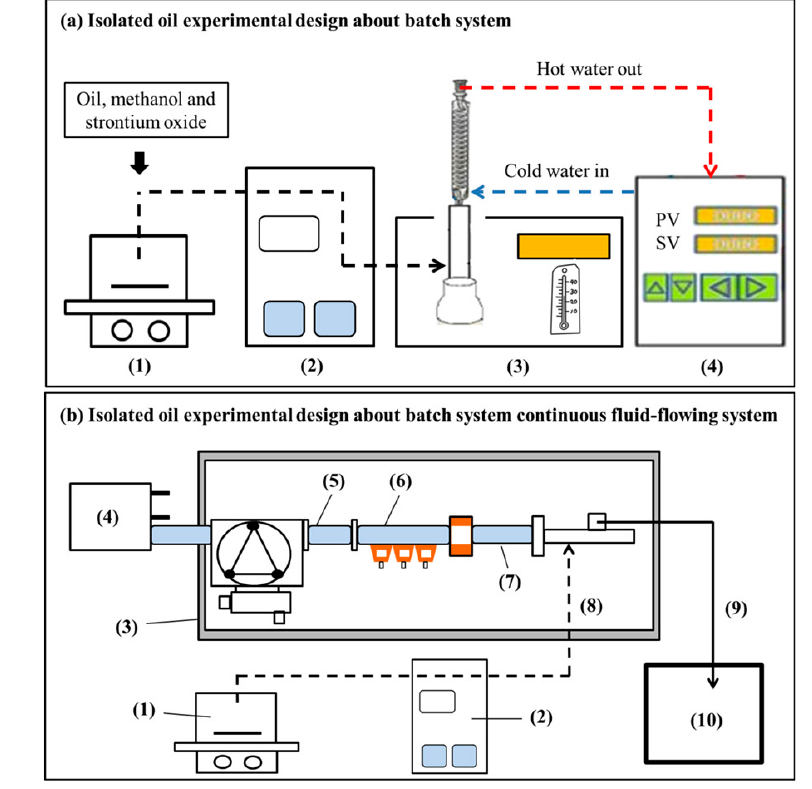
Figure 10. Scheme of batch (above) and flow (below) MW systems for biodiesel synthesis. 1 to 4 in; ( a ) correspond to magnetic stirrer, peristaltic pump, MW and cooling system. 1 to 10 in; ( b ) denote mean stirrer, pump, MW, magnetron head, MW power, three-stub tuner, MW chamber, pipe for input, pipe for output and tank, respectively [56].